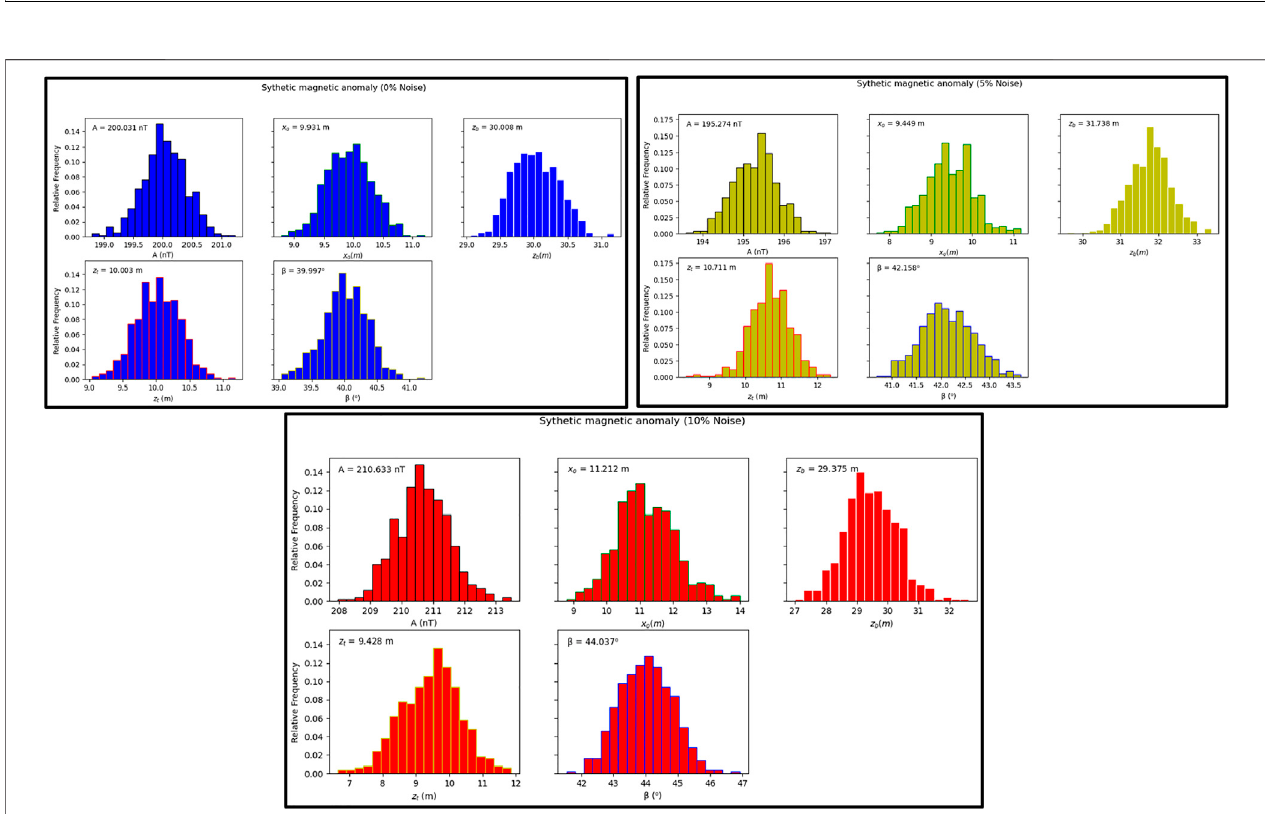
FIGURE6| ProducedhistogramsafteruncertaintyappraisalusingMCMCalgorithm(syntheticmagneticanomaly).Estimatedvaluesindicatedonupper-leftpartof the charts.